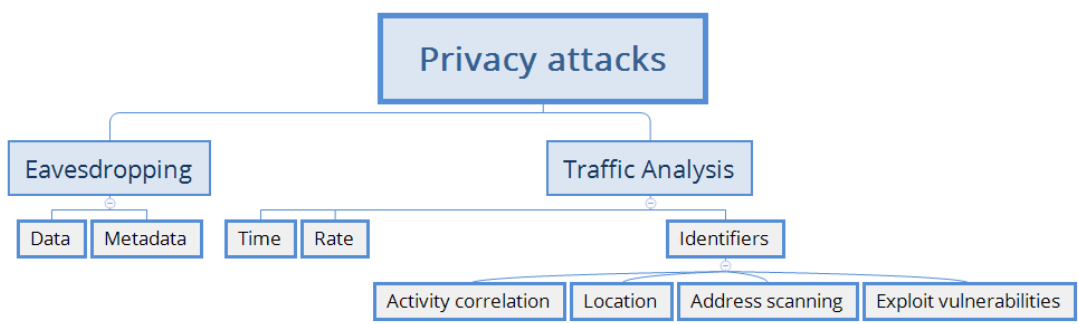
Figure 8. Taxonomy of privacy attacks.